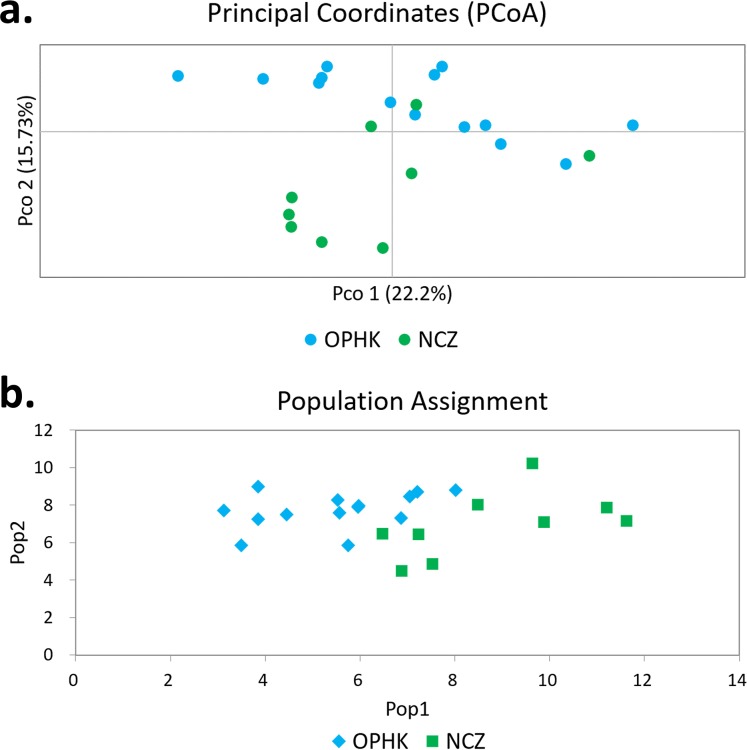
Principal coordinates analysis and assignment tests.(A) Principal coordinates analysis results of Blue-crowned Laughingthrush individuals genotyped at 12 microsatellite loci. Different colours represent postulated populations. (B) A biplot of the respective log-likelihood values for individuals from two populations. With log-likelihoods converted to positive values, the lowest value indicates the most likely population of origin. The abbreviations represent the different Blue-crowned Laughingthrush populations (OPHK, Ocean Park Hong Kong; NCZ, Nanchang Zoo).